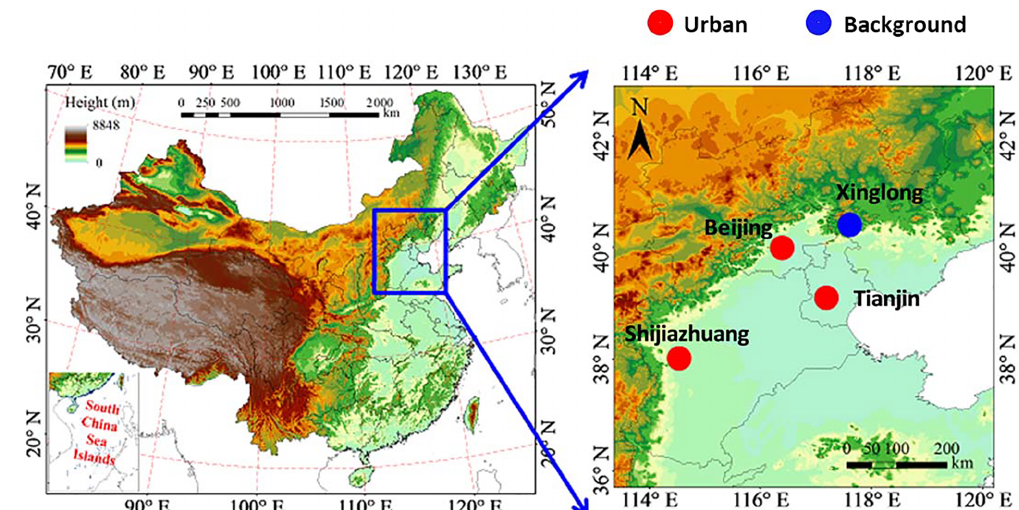
Figure 1. Map of the sampling sites (Beijing, Tianjin, and Shijiazhuang are representative of urban stations, whereas Xinglong represents the regional